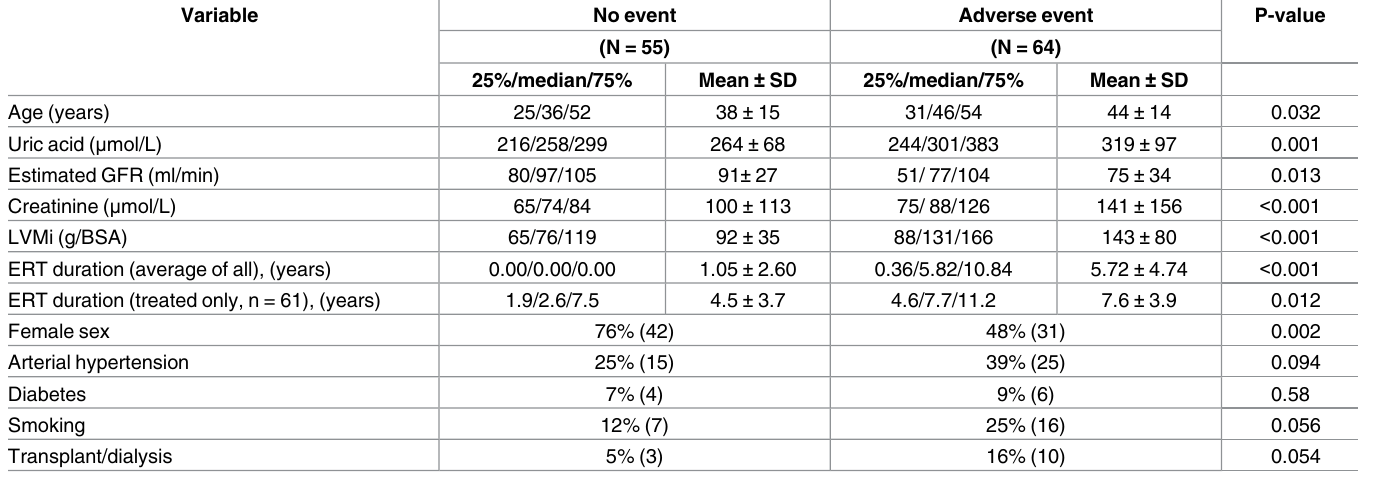
Table 1. Baseline